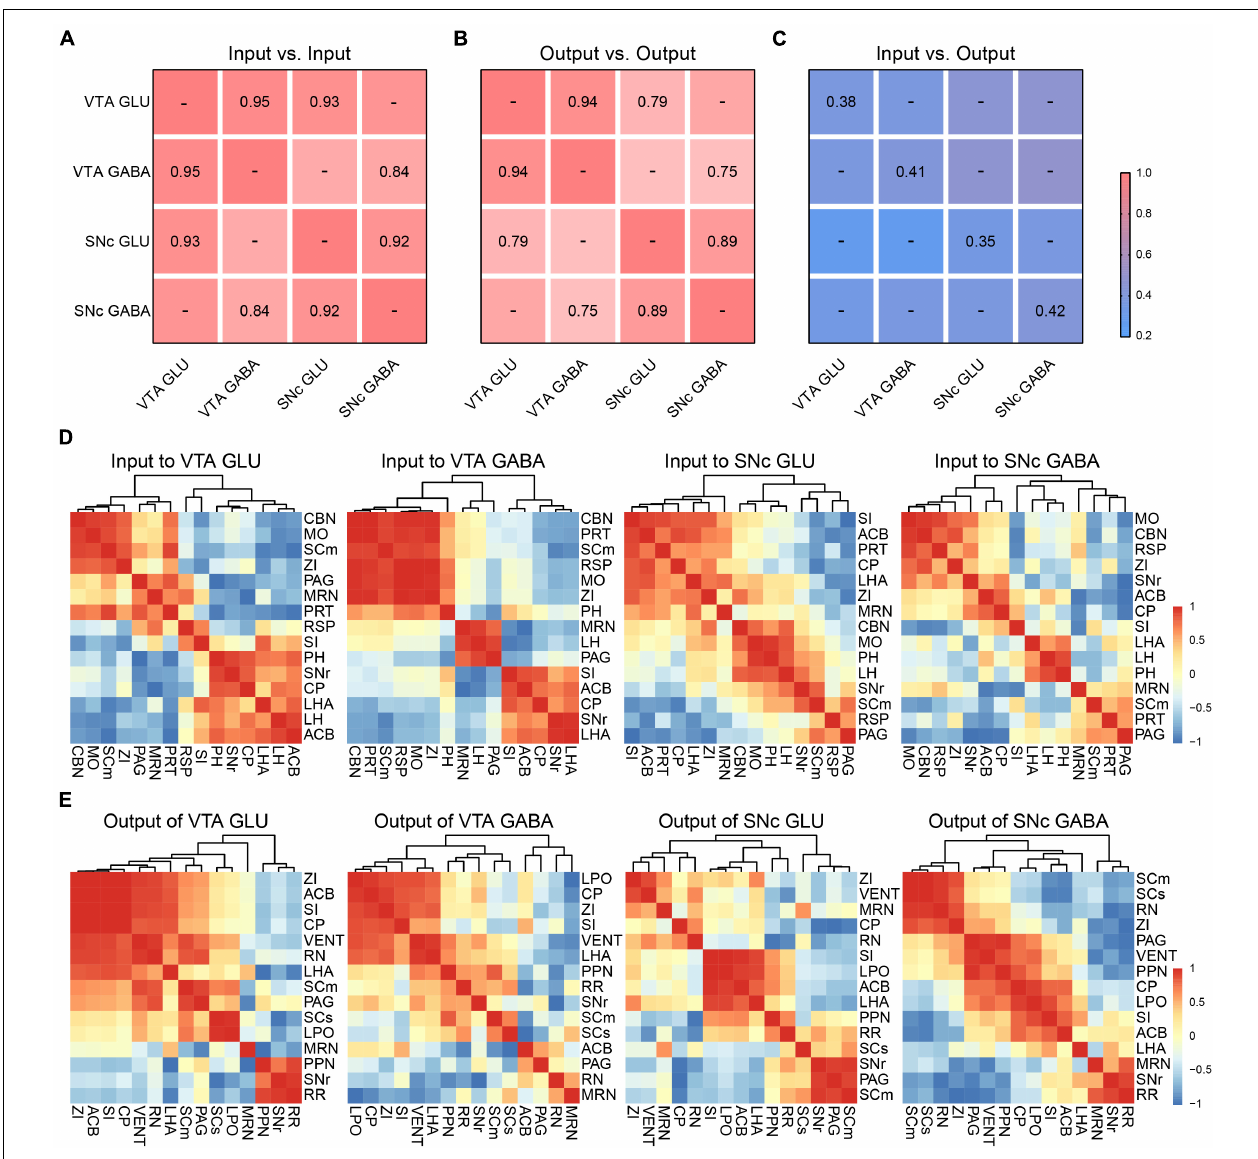
FIGURE 7 | Comparisons of input and output distributions. (A) Matrix of correlation coefficients (CCs) between input distributions of each pair of cell types. CCs were computed at the spatial scale of the 67 major brain regions ( Supplementary Data 1 ). (B) CCs between output distributions of each pair of cell types. CCs were computed at the spatial scale of the 61 major brain regions ( Supplementary Data 2 ). (C) CCs between input and output distributions. CCs were computed at the spatial scale of the 54 major brain regions ( Supplementary Data 2 ). (D) Patterns of Pearson’s correlation coefficient values and cluster trees showing the dissimilarities for the inputs of glutamatergic and GABAergic neurons in VTA and SNc. (E) Patterns of Pearson’s correlation coefficient values and cluster trees showing the dissimilarities for the outputs of glutamatergic and GABAergic neurons in VTA and SNc.